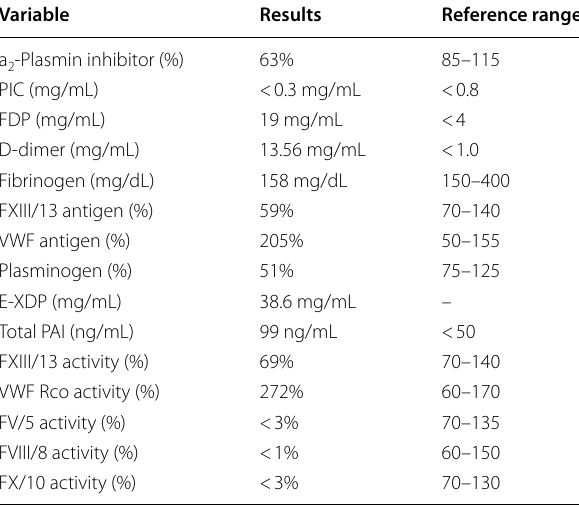
Table 4 Results of JCRG’s Integrated Consignment Screening Test at postoperative day 16